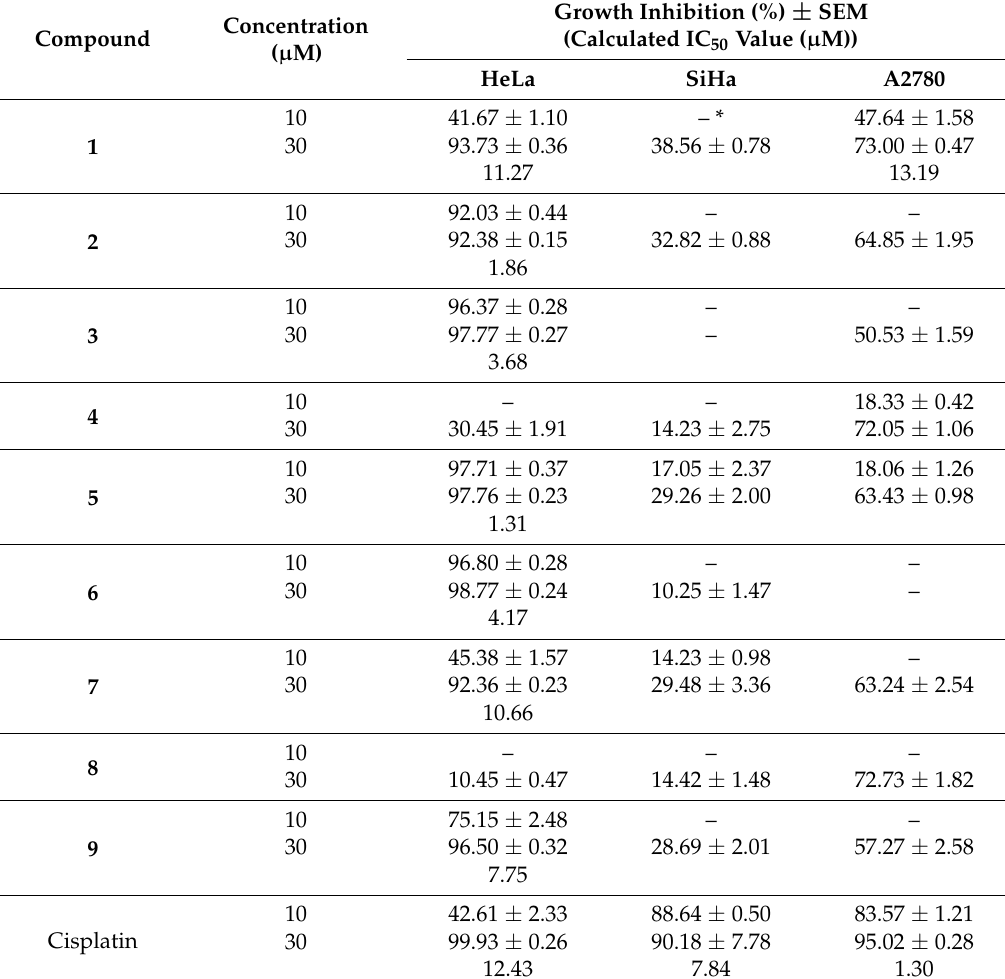
Table 3. Antiproliferative effects of the isolated phenanthrenes ( 1 – 9 ) on human cancer cell lines.